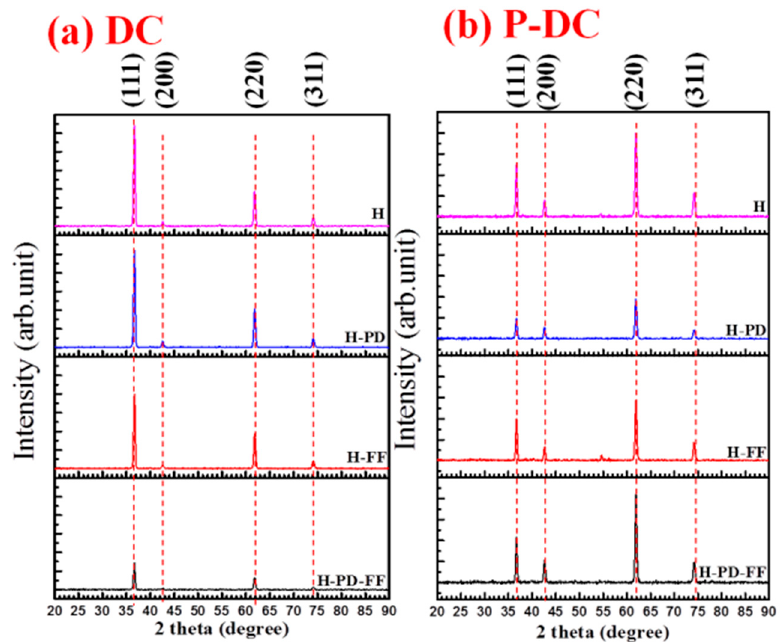
Figure 5. X-ray diffraction patterns of TiN coatings deposited using various HiPIMS operating modes under ( a ) DC or ( b ) P-DC bias.